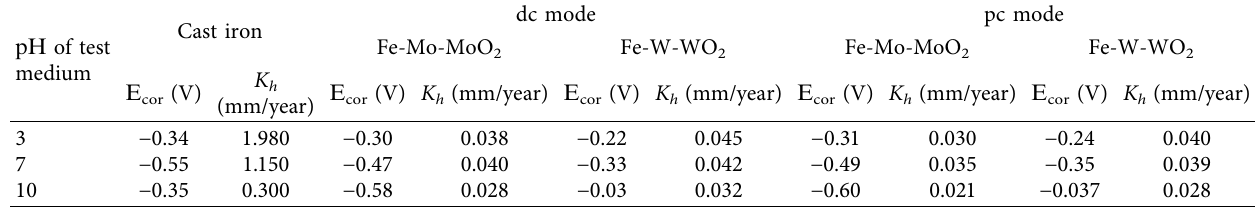
Table 1: The corrosion indices of the cast iron, and Fe-W-WO rO of test medium